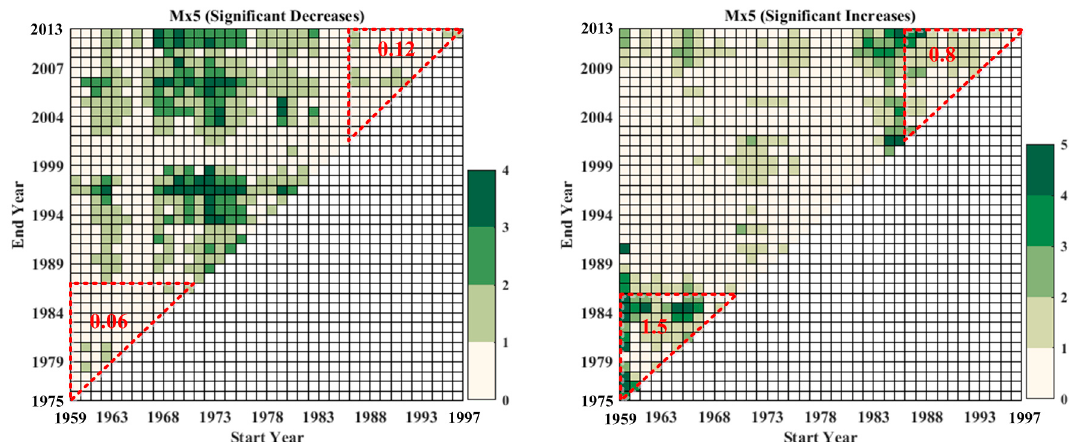
Figure 7. Number of stations with significant decreasing ( left panel ) and increasing ( right panel ) trends in P95 , E–NE and Mx5 during different time spans for periods with different starting years (1959–1997) and ending years (1975–2013). Number of stations within downward red triangles were from 1959 to 1985, while number of stations within upward red triangles were from 1986 to 2013.